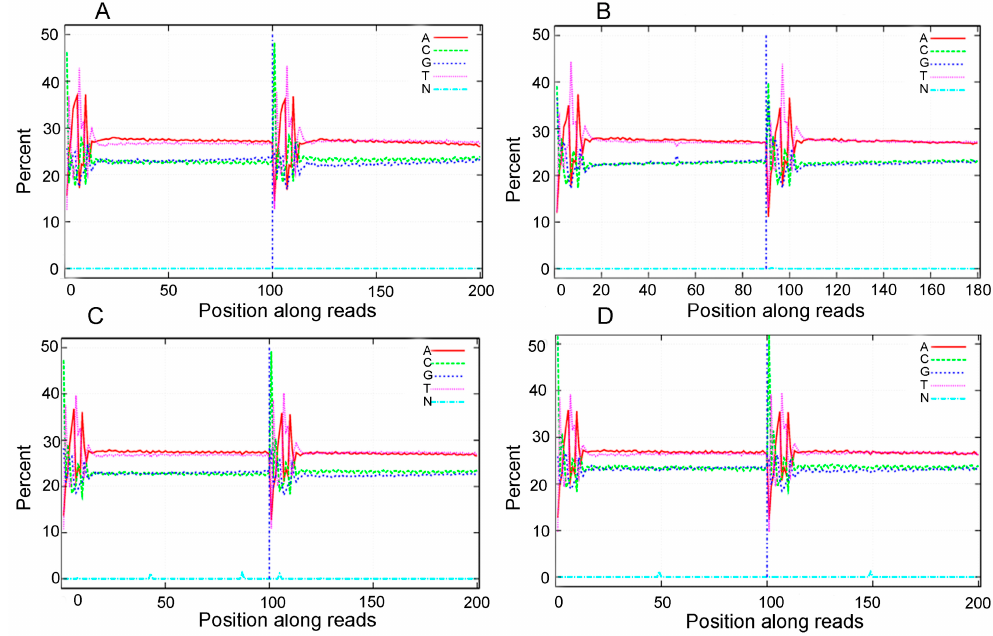
Figure 1. Base composition of clean reads from four Paulownia samples. ( A ): Base composition of clean reads from diploid P. fortunei ; ( B ): Base composition of clean reads from tetraploid P. fortunei ; ( C ): Base composition of clean reads from diploid P. tomentosa ; ( D ): Base composition of clean reads from tetraploid P. tomentosa.